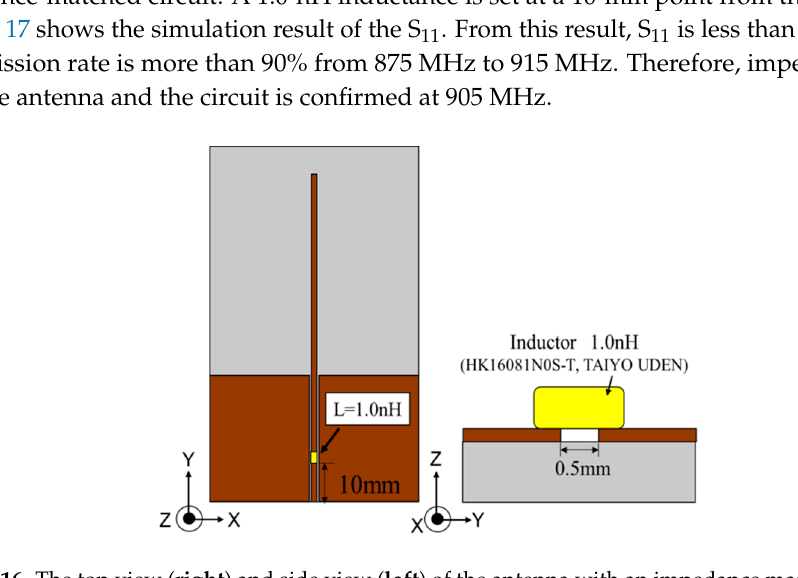
Figure 16. The top view ( right ) and side view ( left ) of the antenna with an impedance matching circuit.